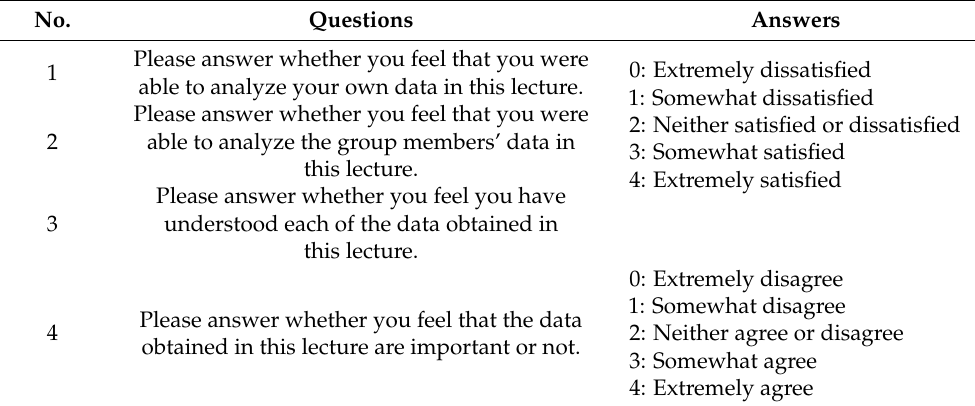
Table 2. Questionnaire after the